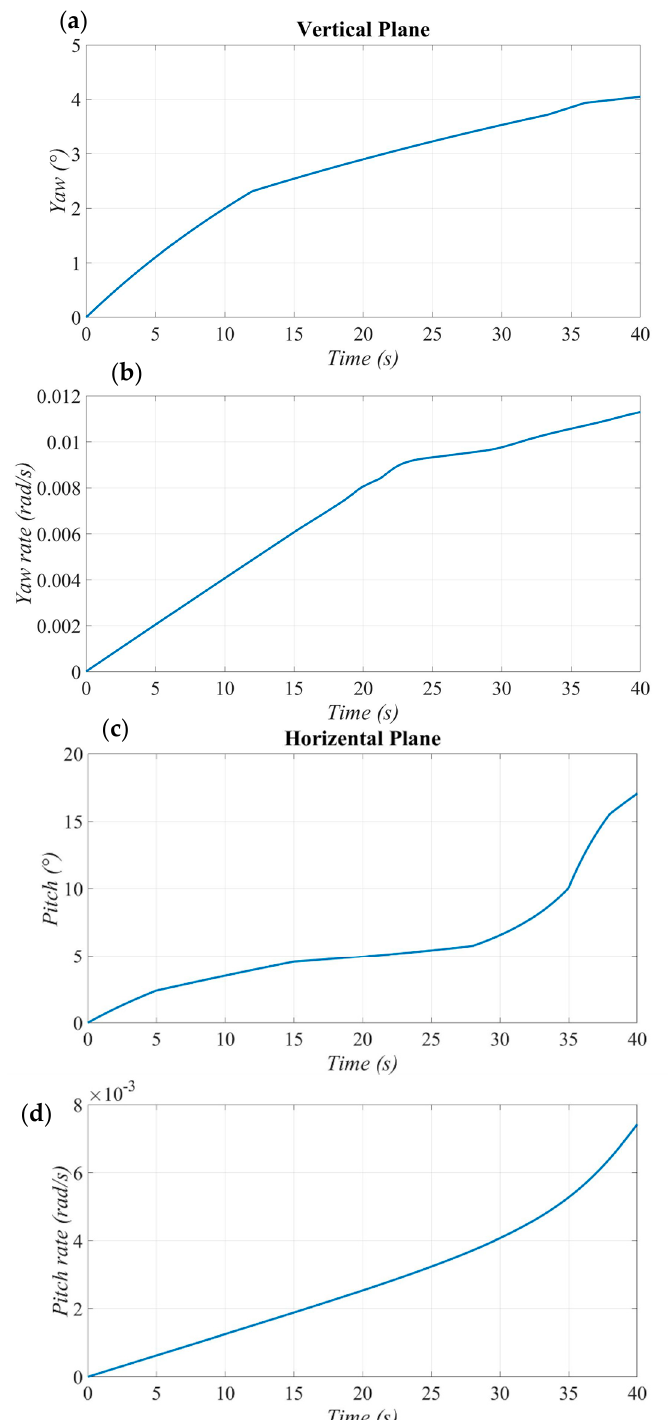
Figure 33. Case 1: ( a ) Yaw angle and ( b ) yaw rate of the vertical rudder plane; ( c ) pitch angle and ( d ) pitch rate of the horizontal rudder plane.